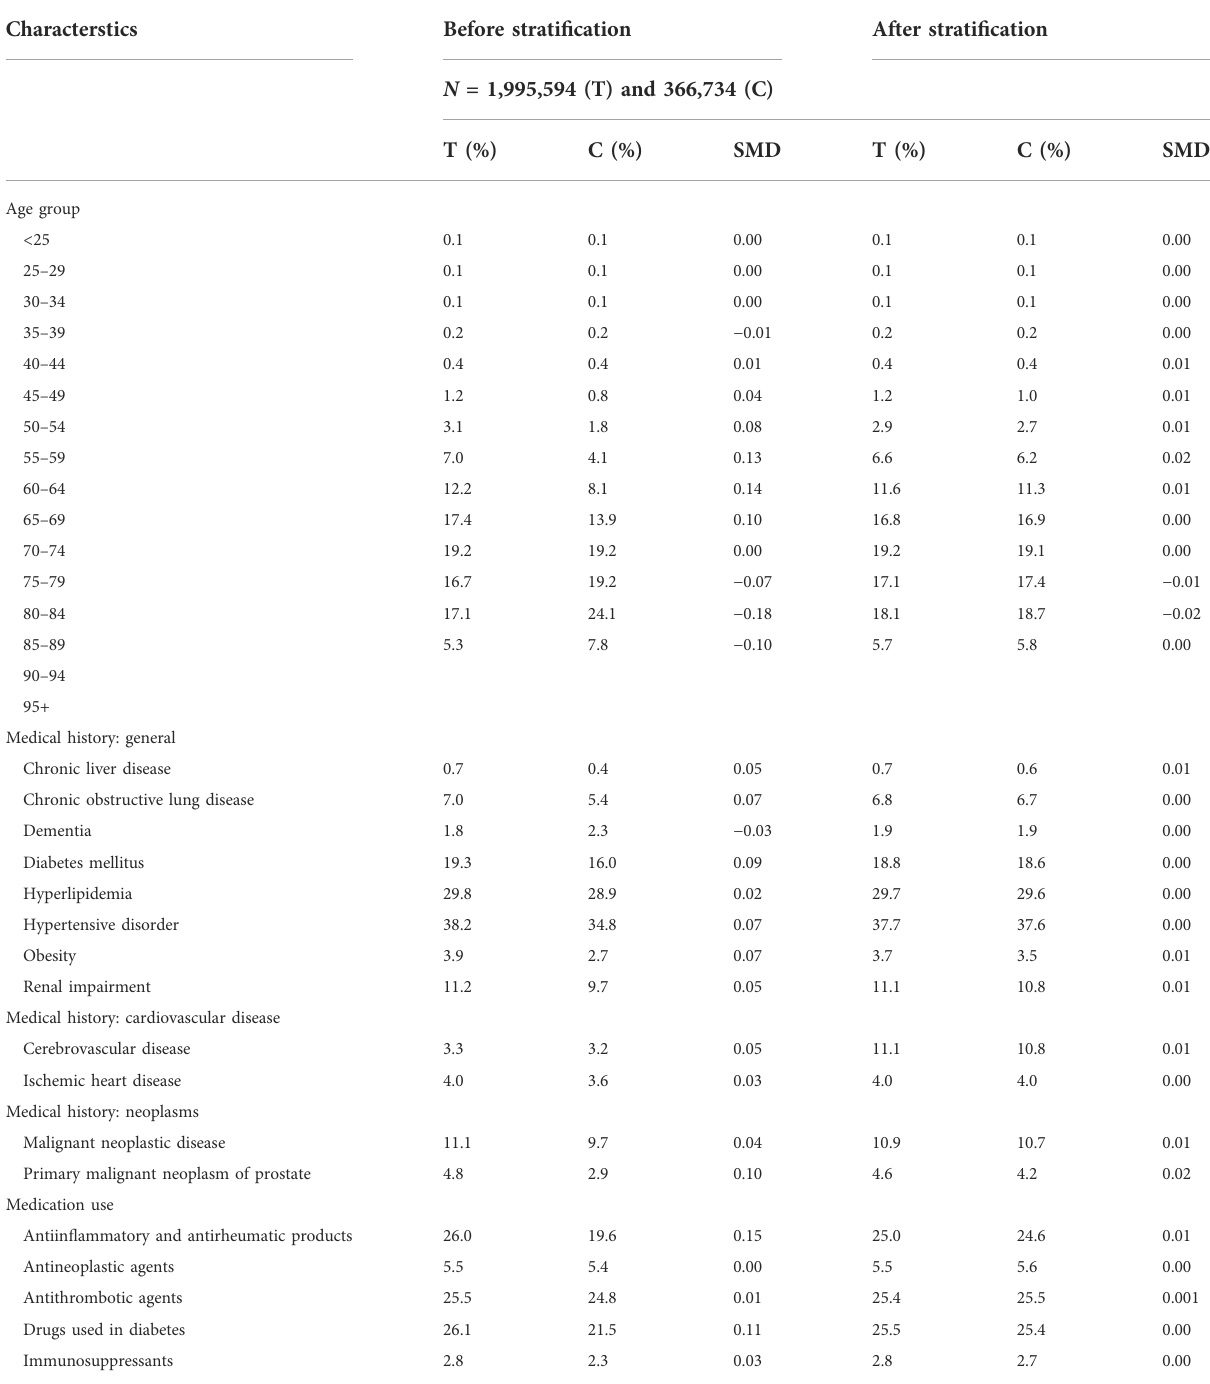
TABLE 1 Baseline patient characteristics for alpha-1 blocker and 5ARI/PDE5 user cohorts in the OpenClaims data source. For each target (T) and comparator (C) cohort, we report the proportion of initiators satisfying selected base-line characteristics and the standardized mean difference (SMD) between the two cohorts before and after strati fi cation. The smaller SMDs after propensity score adjustment demonstrates improved balance between the two cohorts. Open